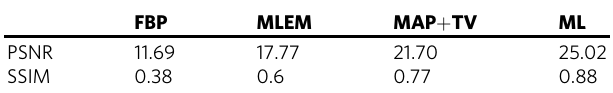
Table 1 PSNR and SSIM of